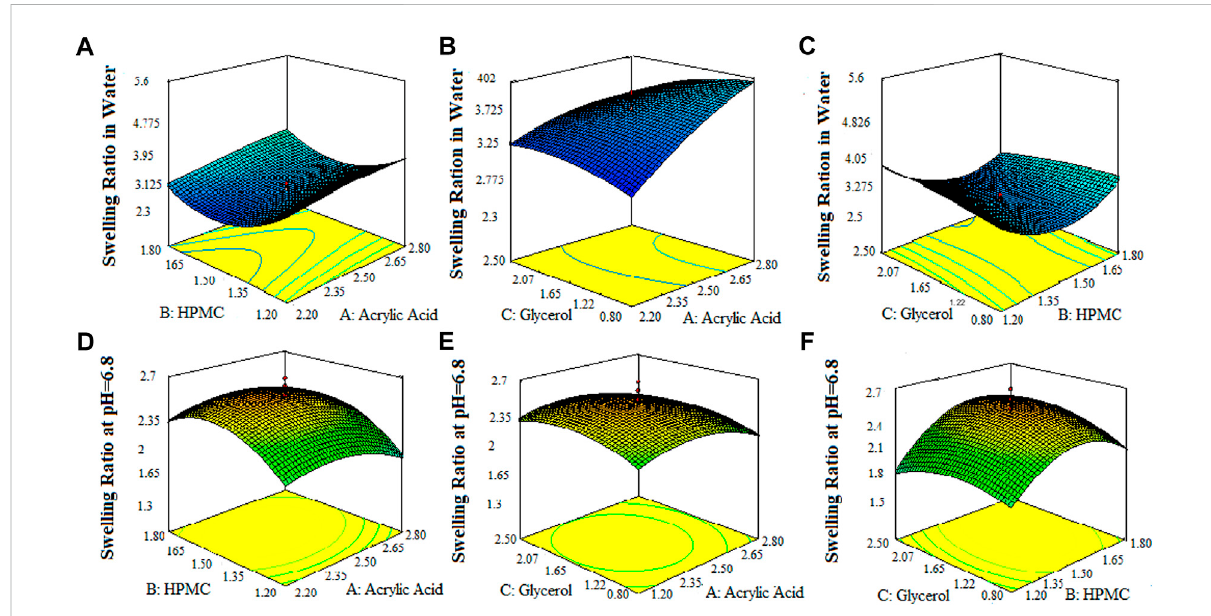
FIGURE 2 3DsurfaceplotsindicatingtheeffectofvariousconcentrationofHPMC-k100,glycerolandacrylicacidondrugcontentswellingratioofSPHsin